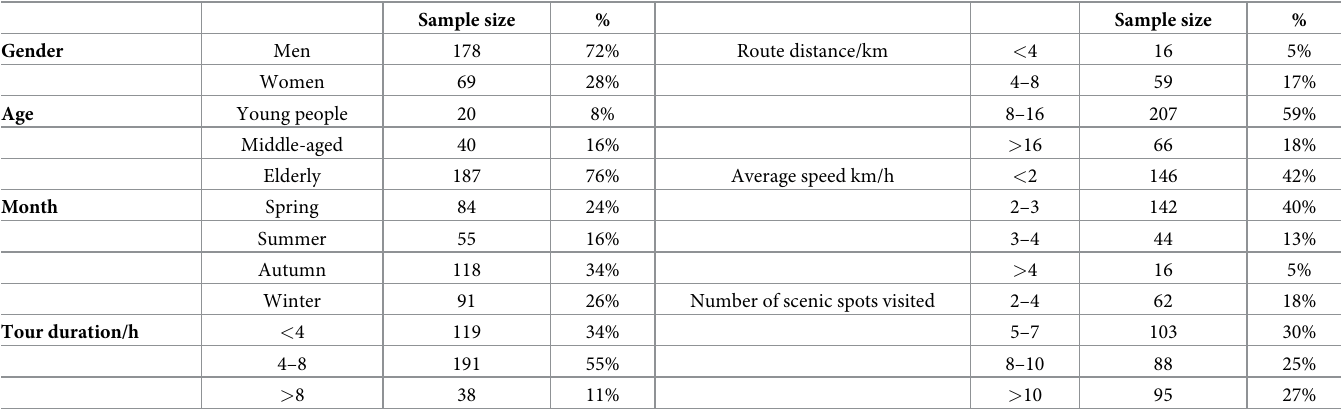
Table 1. Overview of the study